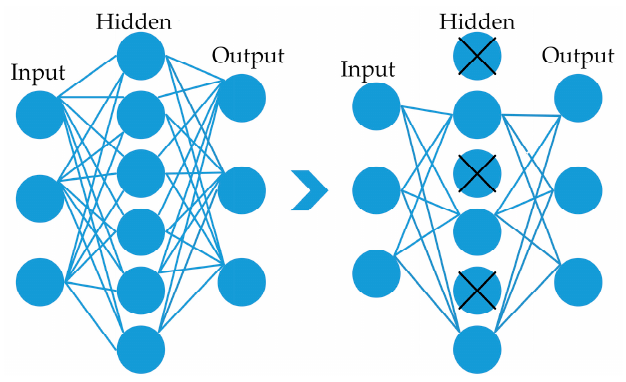
Figure 4. Depiction of a dropout layer with a rate of 0.5% on the right side.